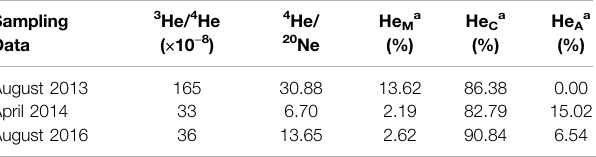
TABLE 3 | Chemical and isotopic compositions of gas from the Panjing observation well. Sampling